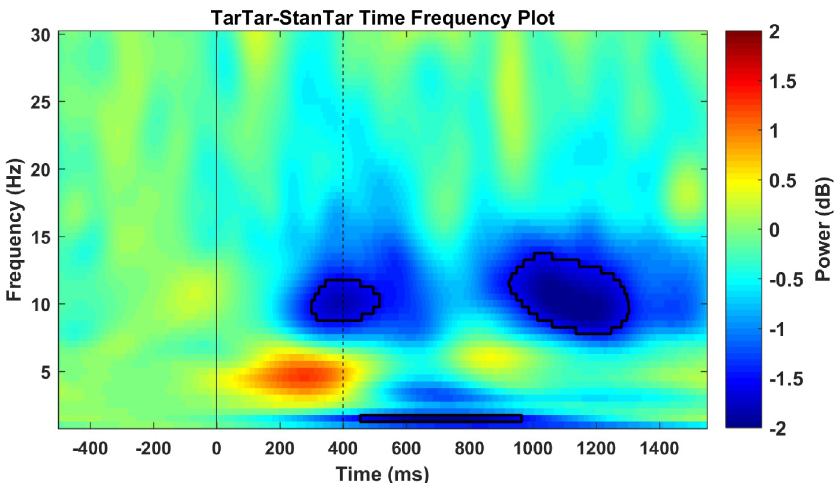
Fig 4. Exploratory analysis of the time-frequency map of power difference between the target-target and standard target conditions (Fig 3C). The demarcated areas correspond to time-frequency differences with a p-value < 0.01 using permutation-based statistical testing with pixel-based multiple comparison correction. The first highlighted area (on the left) indicates desynchronization of alpha in response to auditory target stimuli. The second highlighted area (on the right) indicates over-desynchronization of alpha in response to a visual target under the target-target condition. The third highlighted area (on the bottom) corresponds to desynchronization of the delta band frequency. The solid black line indicates the onset of auditory stimuli and the black dashed line shows the onset of visual stimuli.